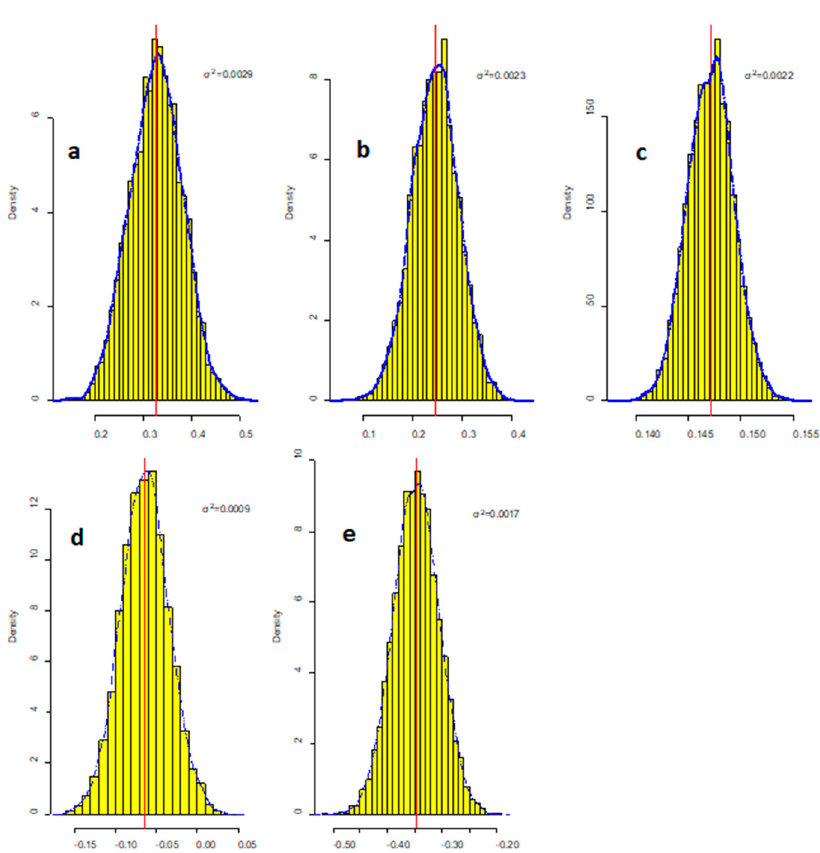
Figure 4. The posterior distribution of coefficients for SSC. Blue dotted line is the kernel density estimation for the coefficients, solid red line is the posterior mean value of coefficients, σ 2 is the posterior variance of coefficients, and yellow bars are histogram of density of posterior coefficients; ( a ) Fe(II) coefficient; ( b ) S(-II) coefficient; ( c ) TP coefficient; ( d ) DEP coefficient; ( e ) Fe(II) × DEP coefficient.